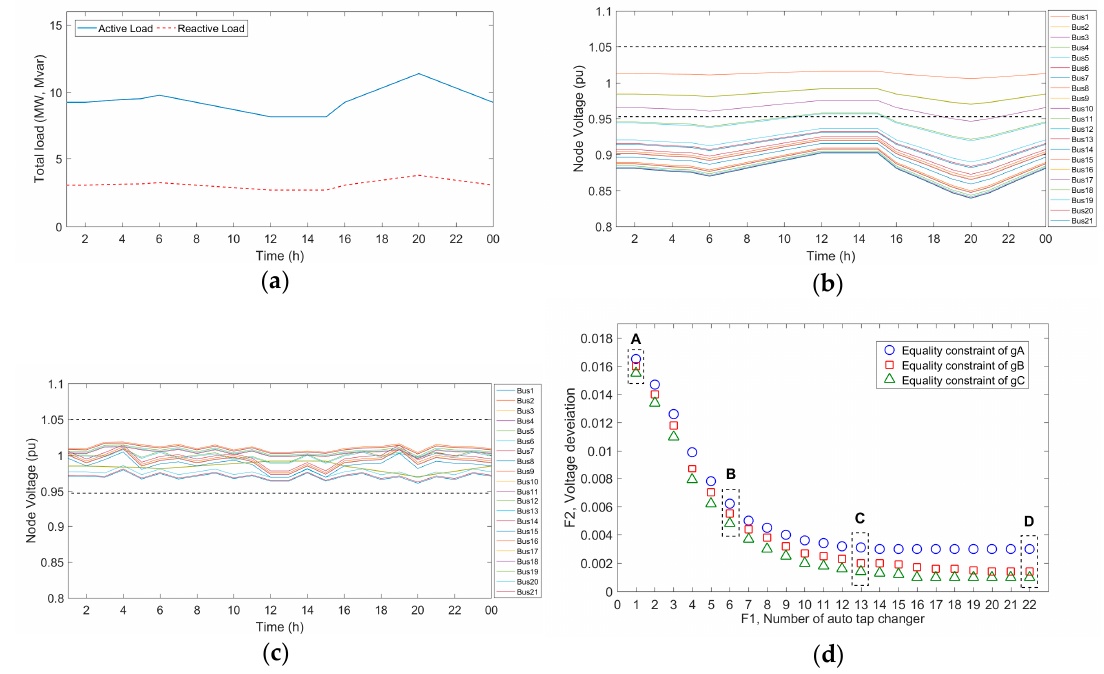
Figure 4. Real distribution network model: ( a ) Daily load profile; ( b ) hourly voltage profile (uncontrolled); ( c ) voltage profile using ATCTrs (controlled); ( d ) Pareto optimal solutions.